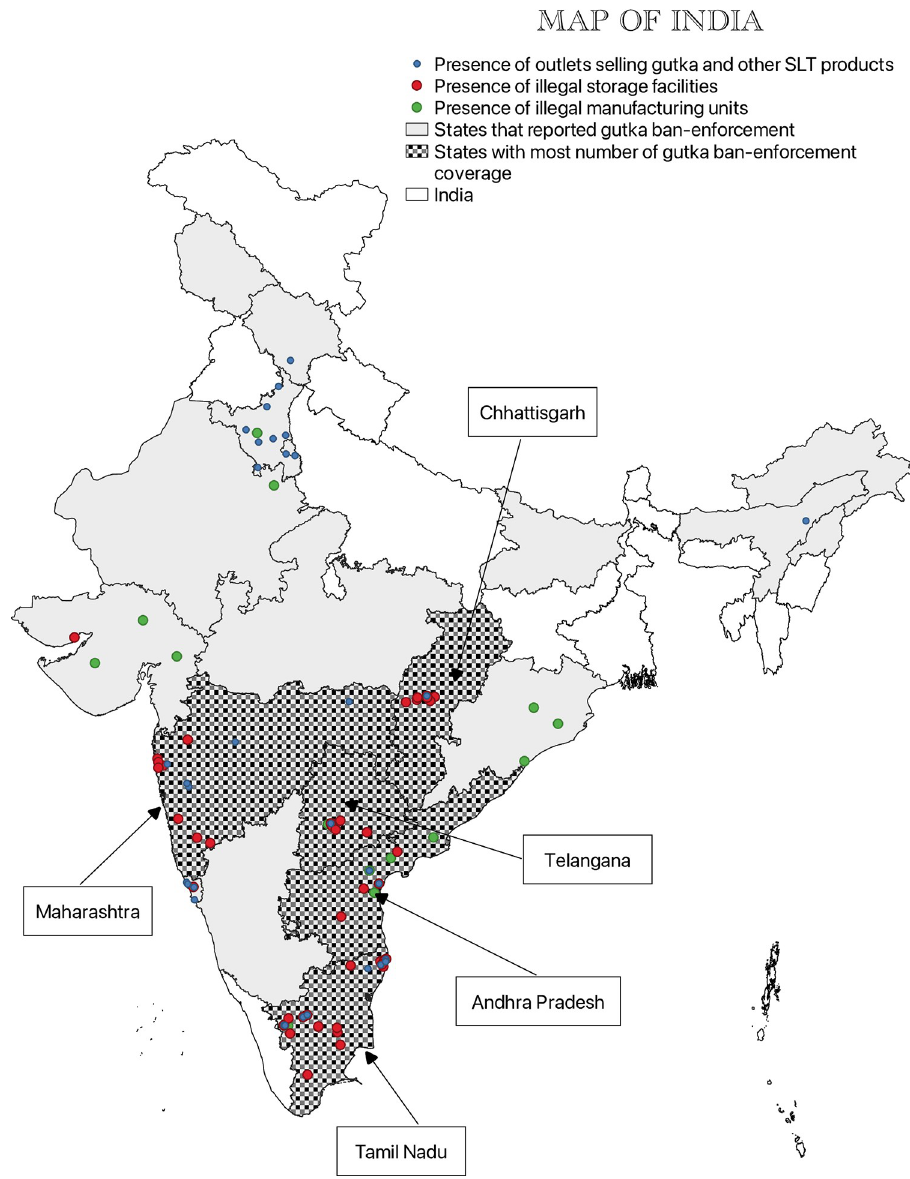
Fig 2. Gutka seizures at manufacture units, storage facilities, and shops as reported in the media. State Boundaries Maps are provided by Data{Meet} Community Maps Project. It is made available under the Creative Commons Attribution 2.5